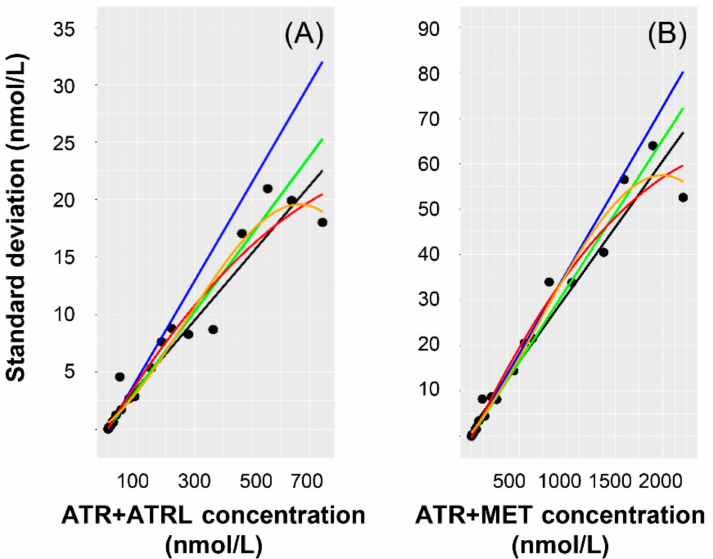
Figure 4. Scatter plots of the standard deviations (SD) of measurement results as plotted against the combined nominal concentrations of ( A ) ATR + ATRL and ( B ) ATR + MET. ATR, ATRL, 2OATR, 2OA- TRL, 4OATR and 4OATRL were spiked to 20 independent blank serum samples at 20 spiking levels (detailed in Supplementary Table S2). Each data point shows the SD of the combined concentrations. The fitted lines and curves have been obtained by applying various linear and nonlinear regression algorithms to the data points. Black, unweighted linear least squares regression. Blue, weighted linear least squares regression with 1/concentration 2 weights. Green, Theil’s regression. Red, 2nd- order unweighted nonlinear least squares regression. Orange, 3rd-order unweighted nonlinear least squares regression.